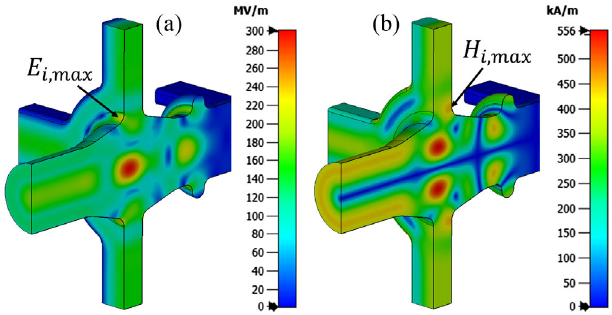
FIG. 11. Maximum E-field (a) and H-field (b) for the incident TM 01 mode from the CWG with 68 MW peak pulse power. ¼ 210 MV m − 1 and H ¼ 448 kA m − 1 Showing E i; max i; max